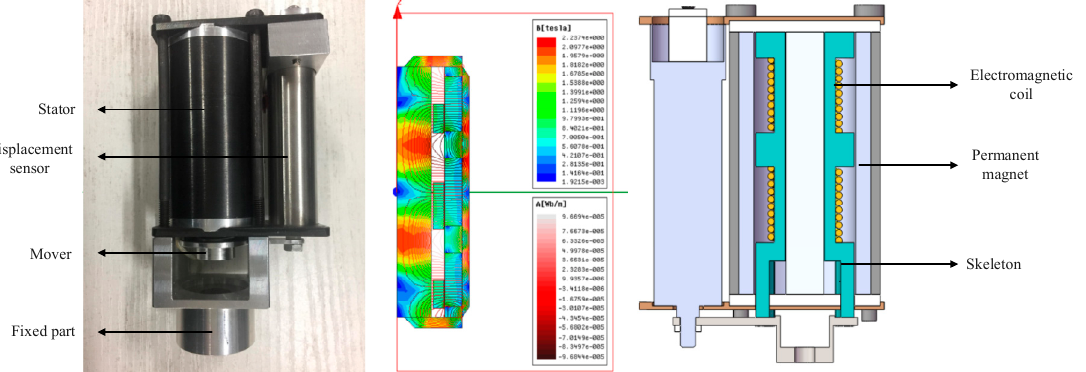
Figure 2. Prototype and magnetic fluxes of the electromagnetic actuator.